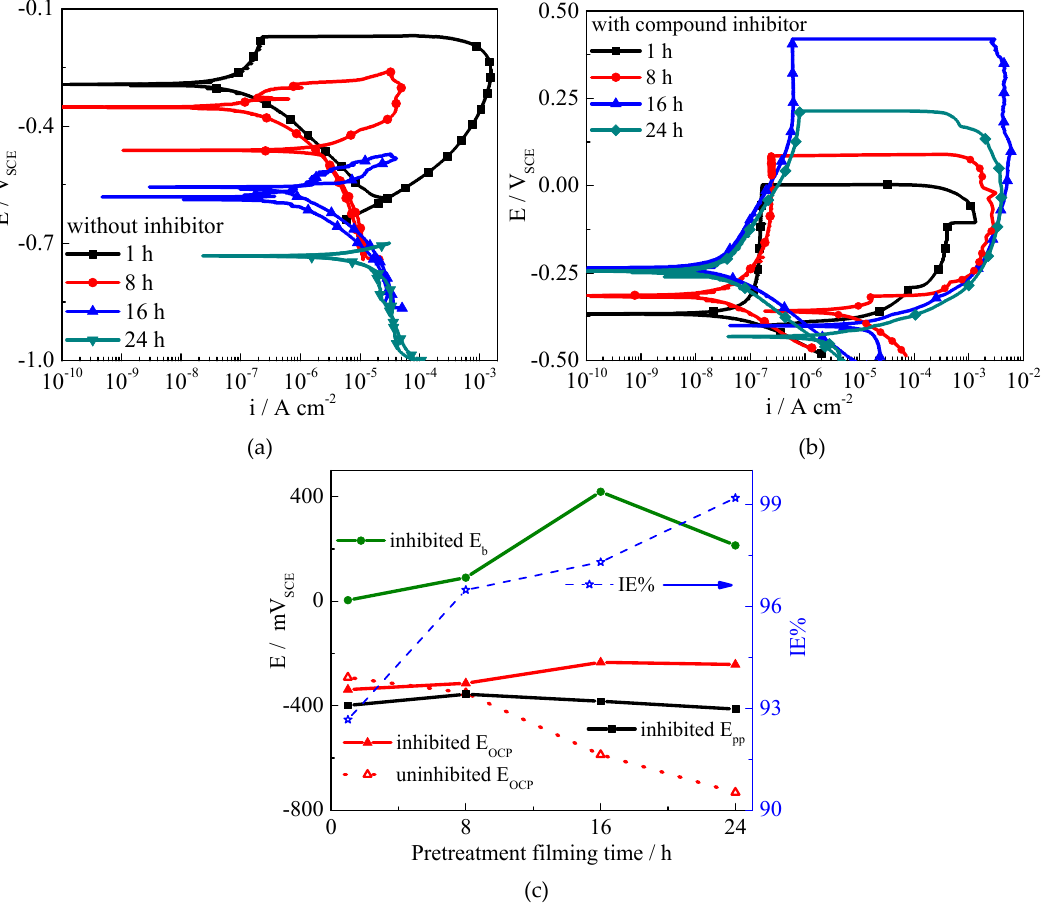
Figure 4. Polarization curves and parameters of Q235 steel immersed in carbonated SCP solution for various times, ( a ) without inhibitor, ( b ) with compound inhibitor, ( c ) electrochemical parameters obtained based on polarization curves.